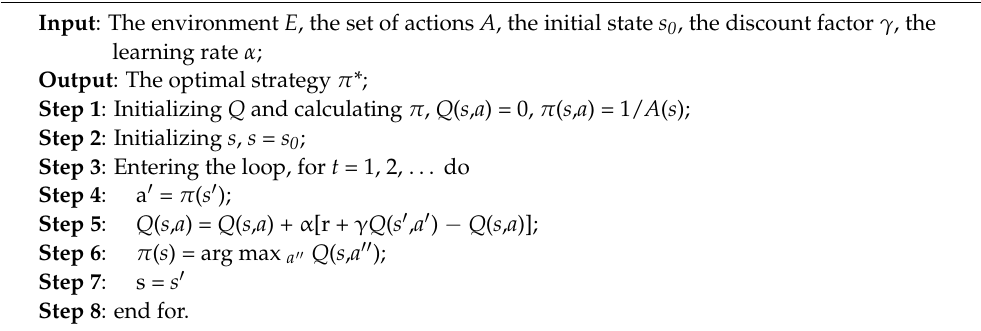
Algorithm 4 Algorithm of Q